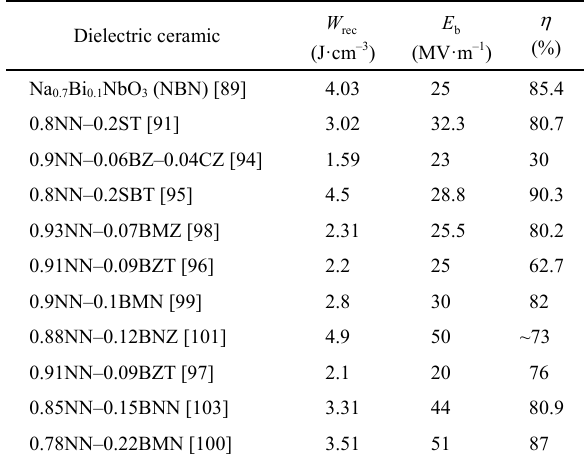
Table 7 Energy-storage properties of NaNbO 3 -based bulk ceramics Dielectric ceramic